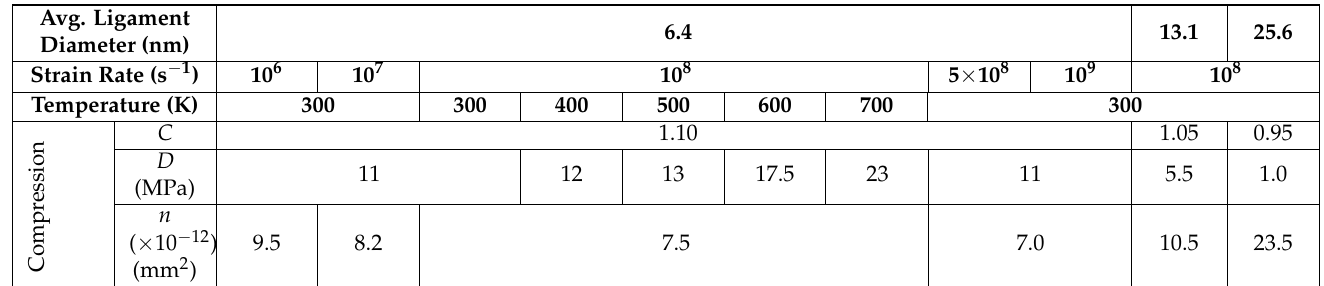
Table 1. Equation (1) parameters values according to Saffarini et al.